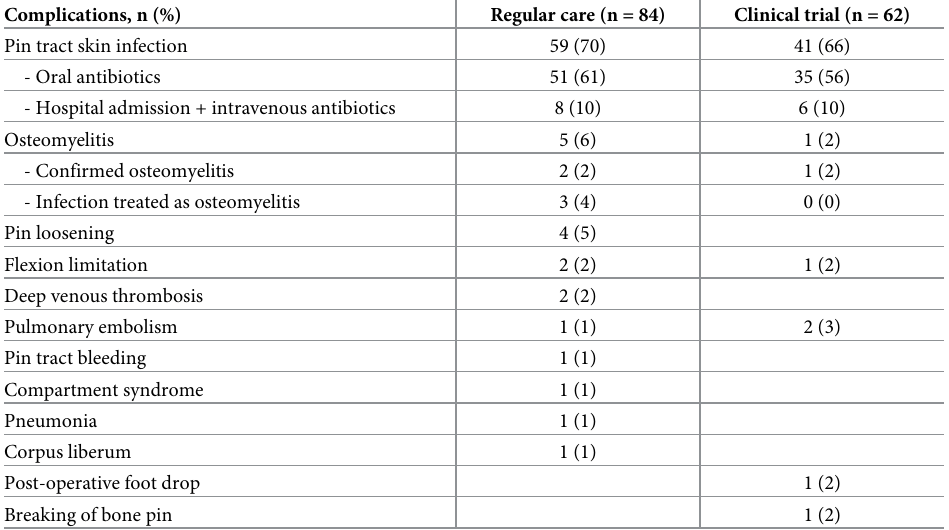
Table 2. Complications during and after treatment with knee joint distraction in regular care and in clinical